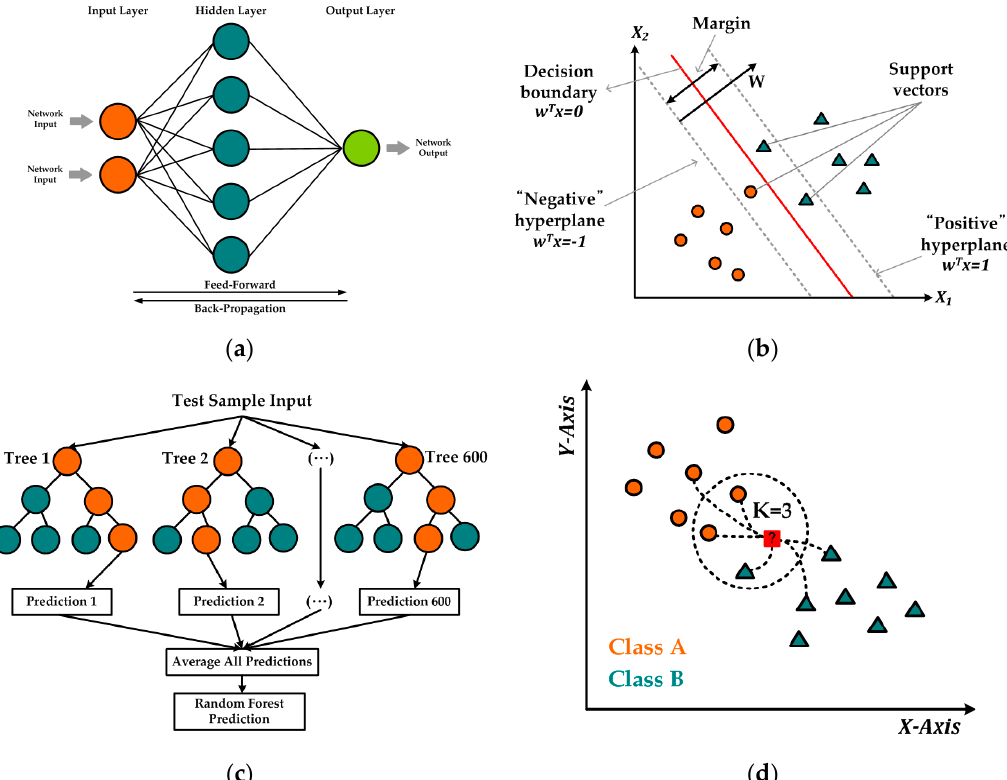
Figure 3. Diagram of machine-learning model. ( a ) ANN, ( b ) SVM, ( c ) RF, ( d ) KNN.